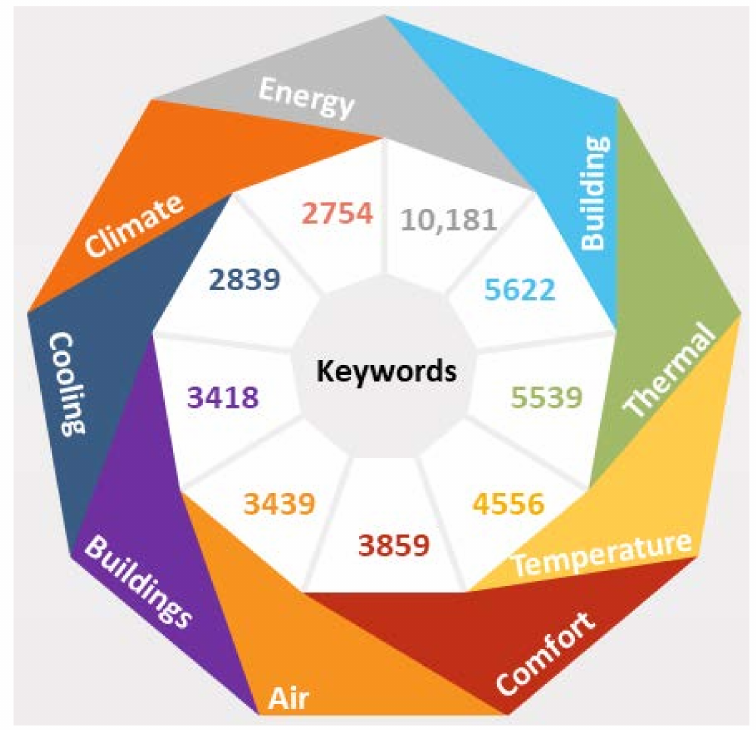
Figure 5. Occurrence of the most-used